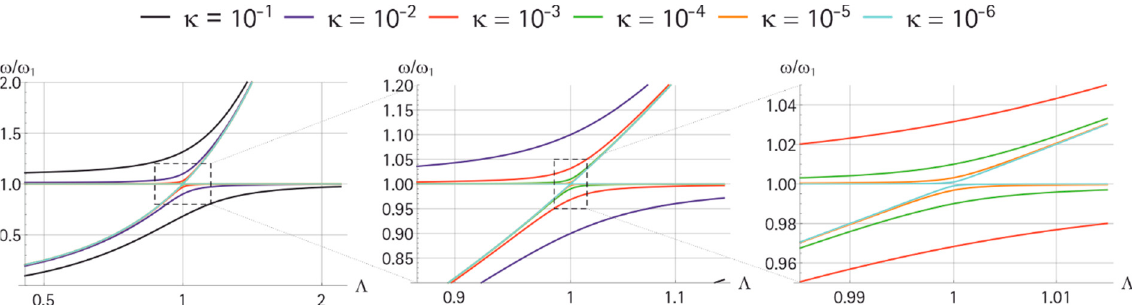
Figure 4. Parameter dependence of the system eigenfrequencies ω L and ω H for a variation of the frequency-mistuning parameter Λ . The zoom-level is increased from the left to the right in the plot. The used parameters were: m = 1 kg, k = 1 N/m, and κ = 10 − 6 . . . 10 − 1 .